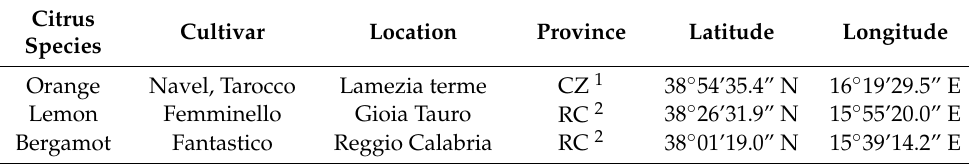
Table 2. Citrus orchards and their locations involved in the study.